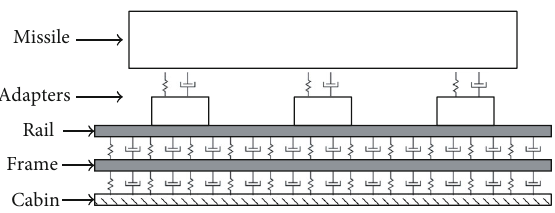
Figure 2: Missile-adapter-rails-frame coupling